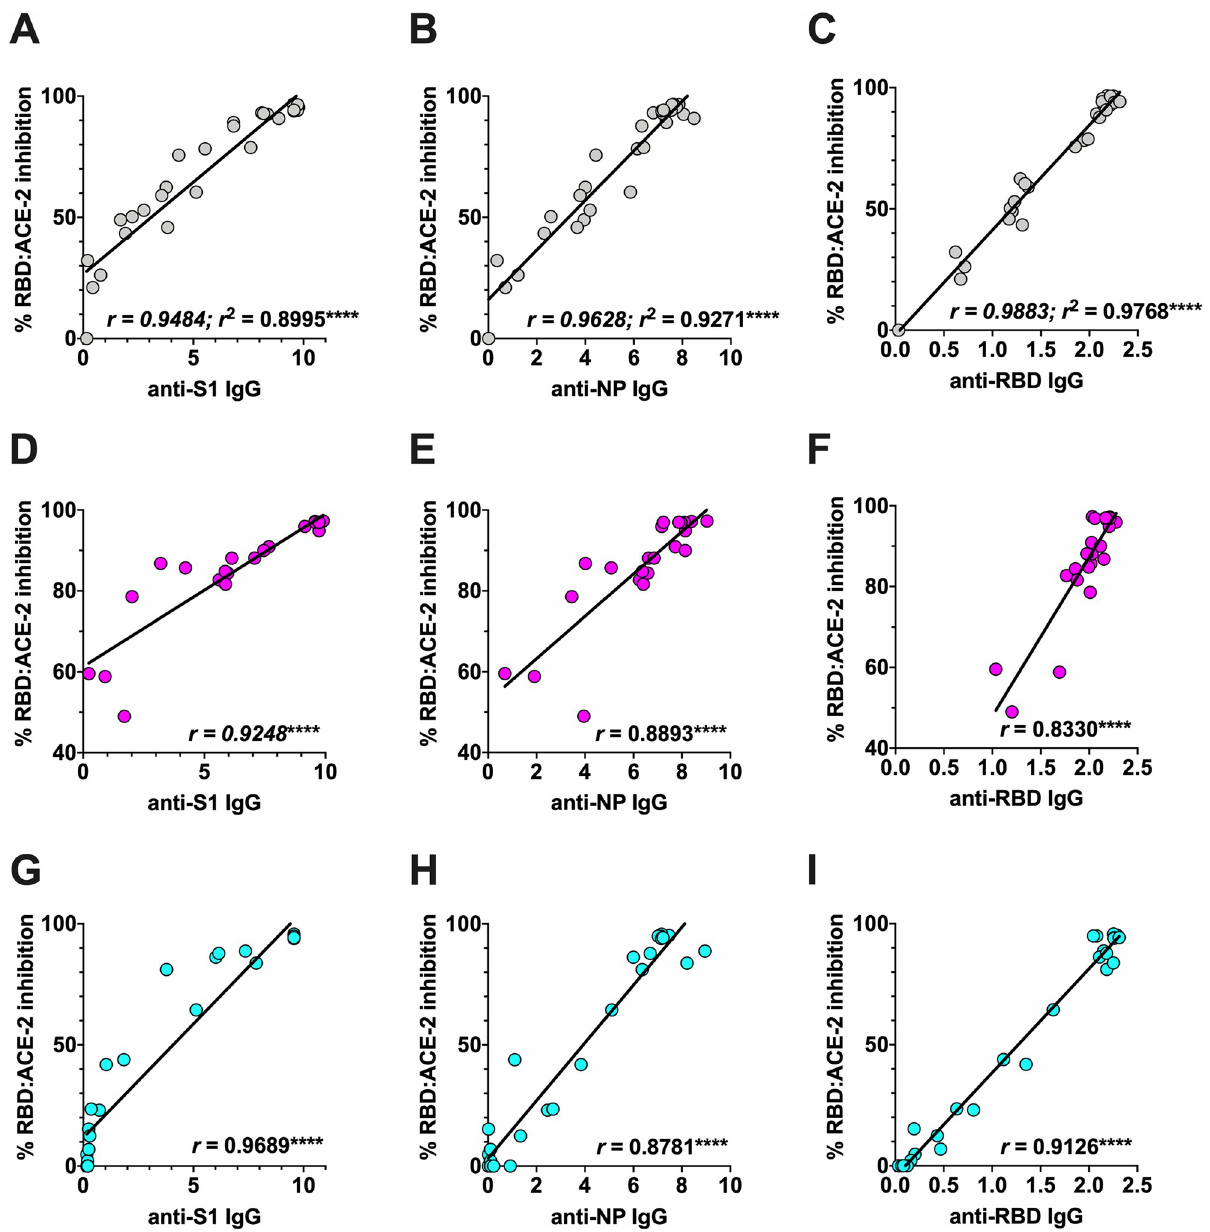
Fig 4. Correlates of RBD:ACE-2 binding inhibition potency. The relationship between anti-S1 IgG, anti-NP IgG or anti-RBD IgG levels and sRBD: ACE-2 inhibition potency was investigated by Pearson’s correlation test (when data displayed Gaussian distribution) or by Spearman’s nonparametric correlation test (when data were not normally distributed), with the significance of any correlation reported by two-tailed p test. (A-C) Correlation between anti-S1 IgG, anti-NP IgG and anti-RBD IgG to RBD:ACE-2 binding inhibition potency across the cohort (excluding patients 12 and 17). (D-E and F-H) As in A-C , though describing correlates specifically for cohort members that seroconverted with 7 days pso, or after 7 days pso, respectively. Abbreviations/symbols: r describes correlate coefficients; r 2 describes the coefficient of determination (for Pearson’s correlation test only); ���� p �